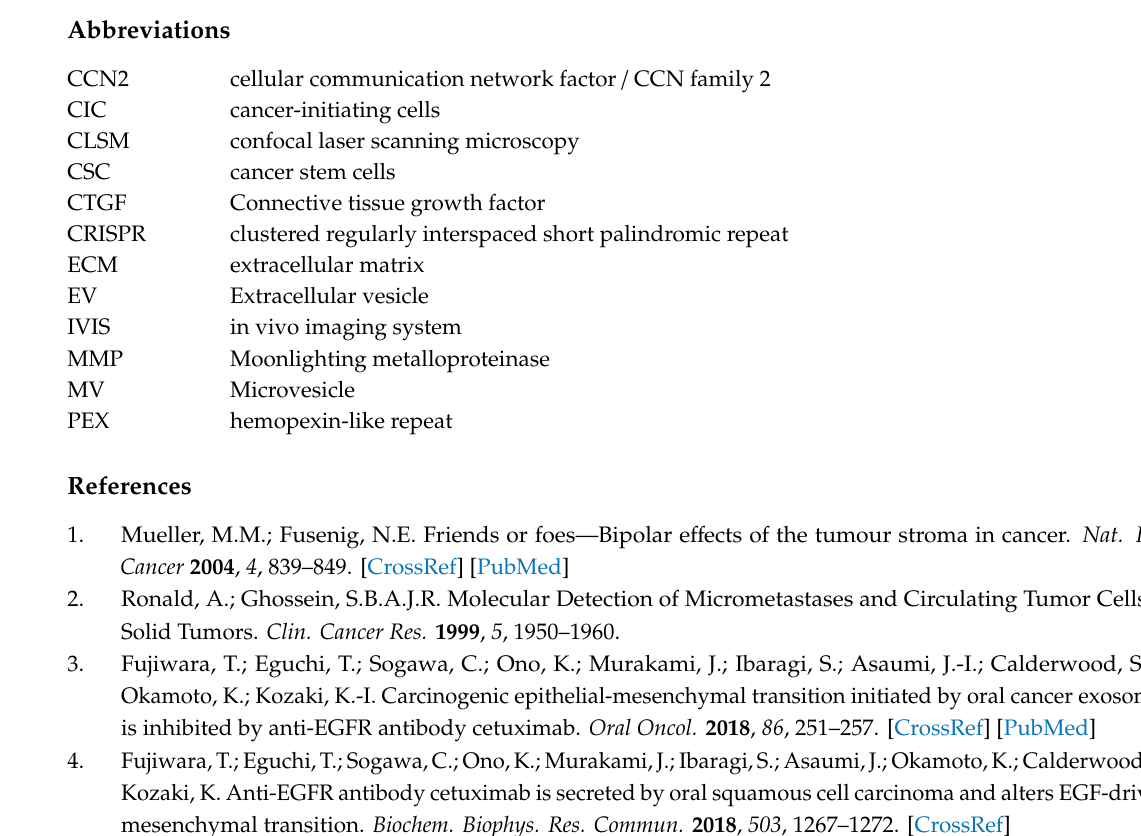
Figure S1. Full images of Western blotting of MMP3 (A), CD9 (B), and GAPDH (C), supporting Figure 1C; Figure S2. Western blotting of MMP3 and GAPDH in recipient Colon26 cells after the addition of LuM1-EVs; Figure S3. Basic data of genome editing, supporting Figure 3; Figure S4. Full images of Western blotting of CCN2 / CTGF (A), CD9 (B), and GAPDH (C), supporting Figure 4E; Figure S5. Protein concentrations in each EV fraction derived from Colon26, LuM1, and MMP3-KO cells; Figure S6. Full images of Western blotting, supporting Figures 3F and 6A; Figure S7. Full images of Western blotting of MMP3 (A), CCN2 / CTGF (B), and GAPDH (C), supporting Figure